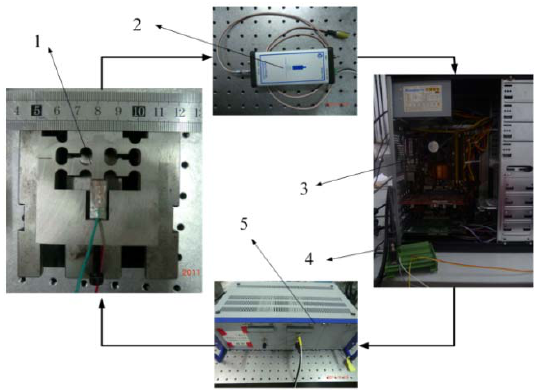
Figure 6. Schematic of the experimental